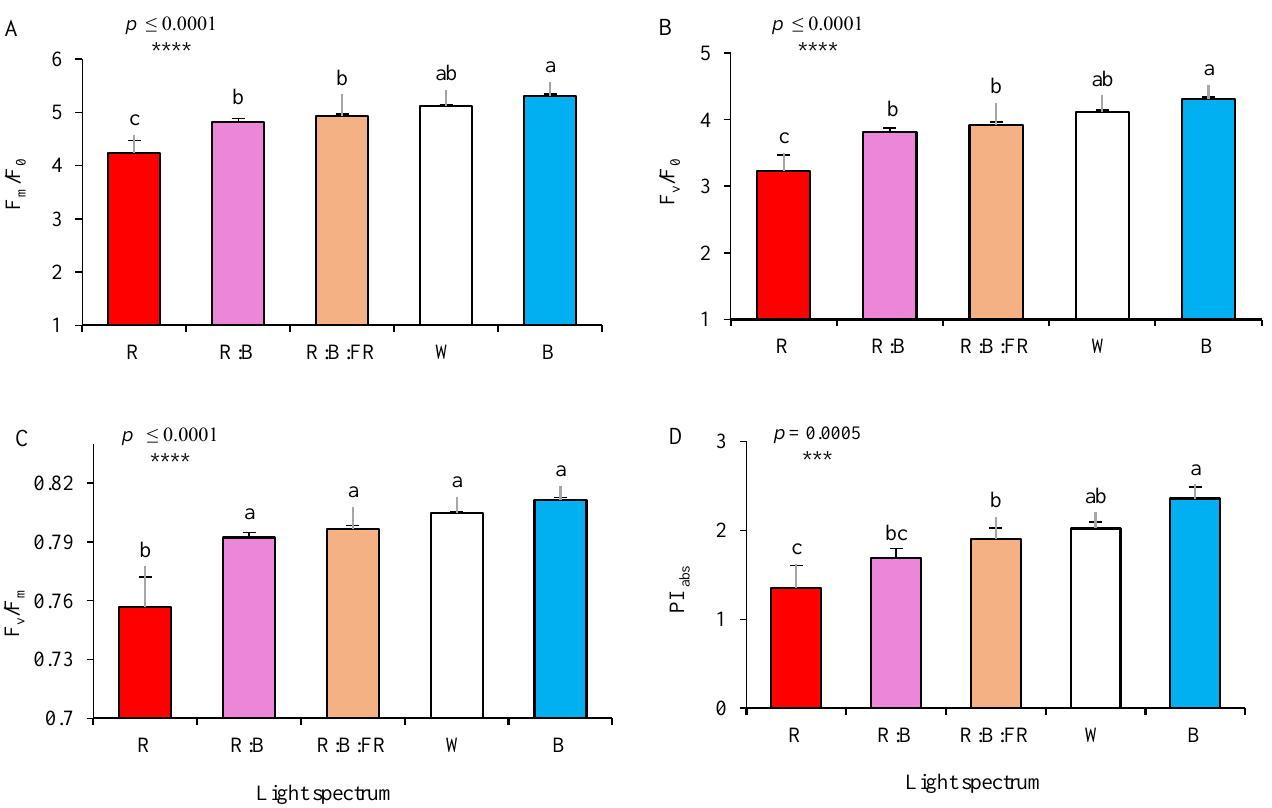
Figure 6. Relative maximal and minimum chlorophyll fluorescence (F m /F 0 ) ( A ), maximum efficiency